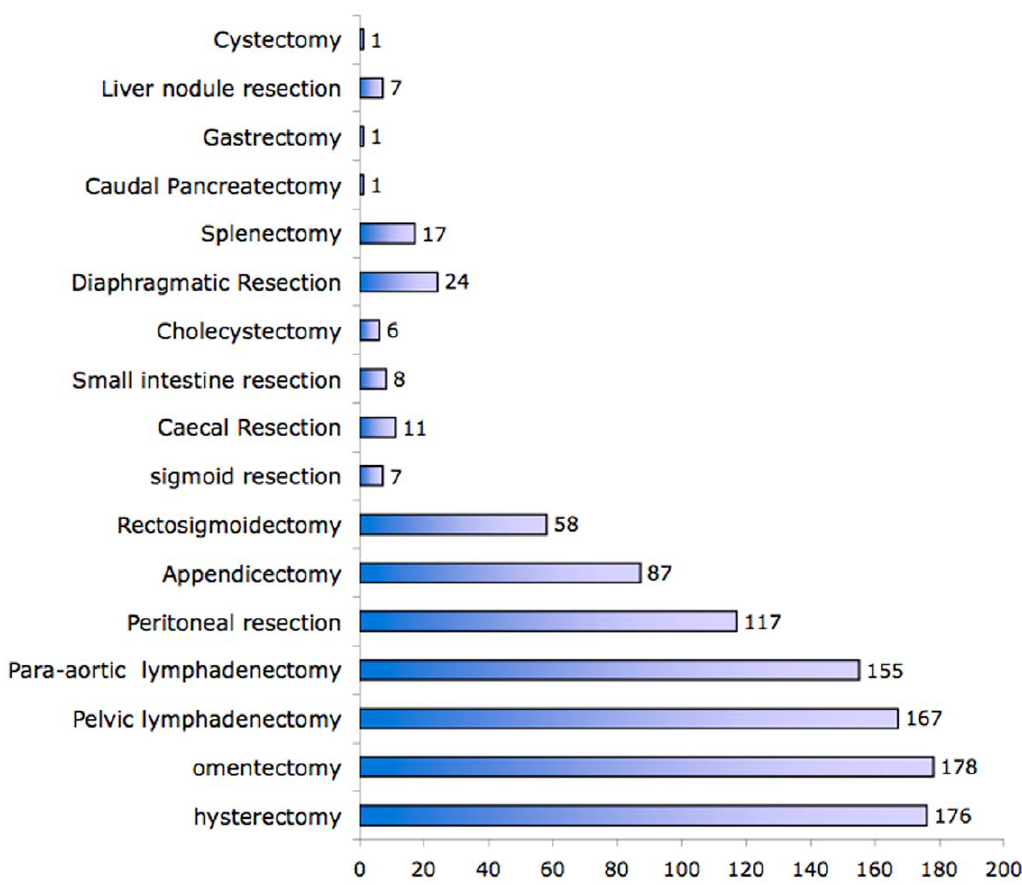
Figure 1. Surgical procedures performed.